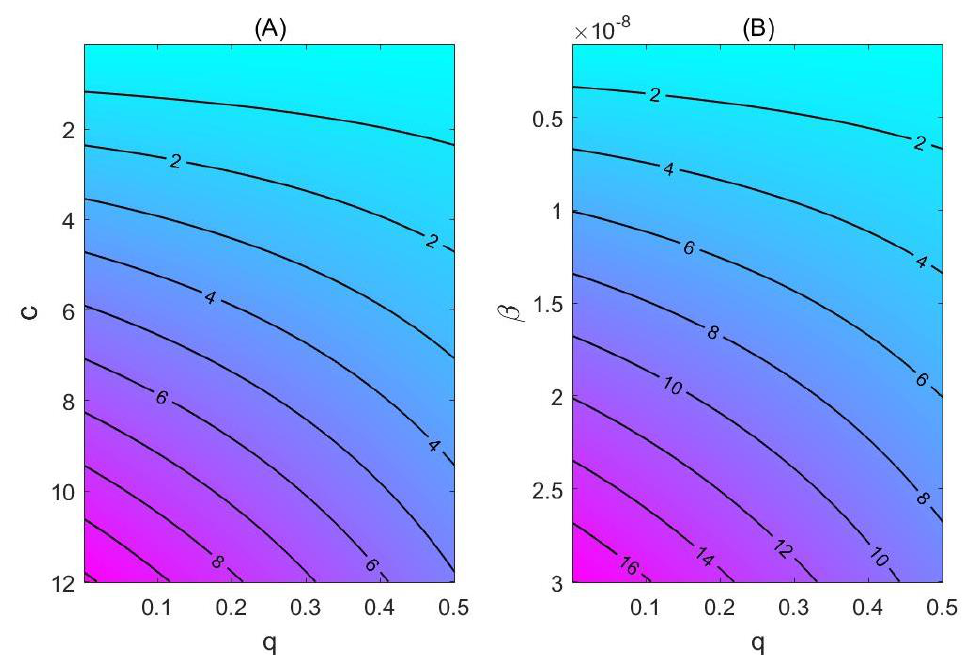
Figure 4. Contour plot of R_c, with the parameter of baseline transmission probability and the contact rate, c ( A ), or the quarantine rate, q ( B ). ( B ) shows that a higher transmission probability of the virus will significantly increase the basic reproduction number.